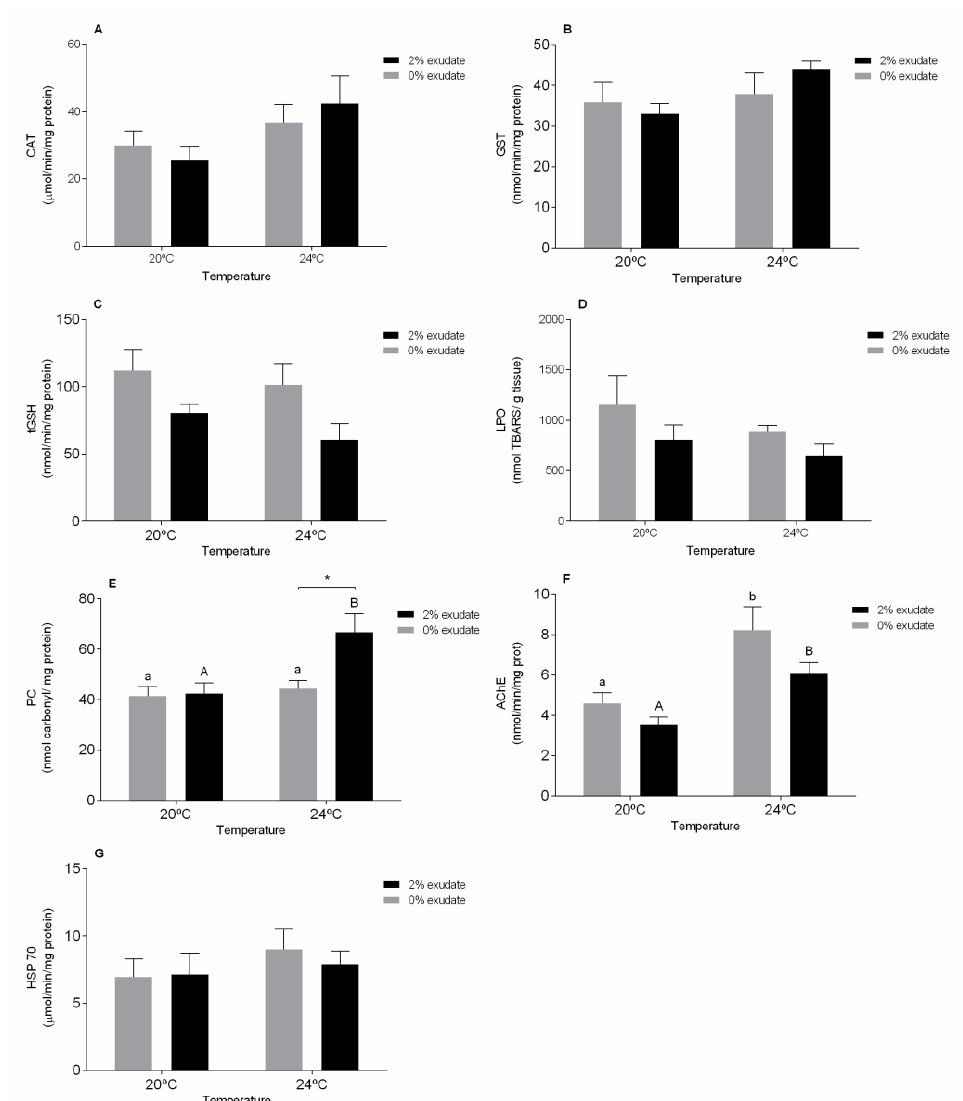
Figure 2. Biochemical biomarker responses of M. galloprovincialis digestive gland after 96 h of exposure to A. armata exudate at different temperatures. ( A ) Catalase (CAT), ( B ) glutathione-S-transferase (GST), ( C ) total glutathione (tGSH), ( D ) lipid peroxidation (LPO), ( E ) protein carbonylation, ( F ) acetylcholinesterase (AChE), and ( G) heat shock proteins (HSP70). Asterisk (*) indicates a significant difference compared with the 0% and 2% of A. armata exudate from the same temperature and the different lower-case letters point at differences in the 0% exudate treatments at the different temperatures and the upper-case letters indicate differences in the 2% exudate treatments.